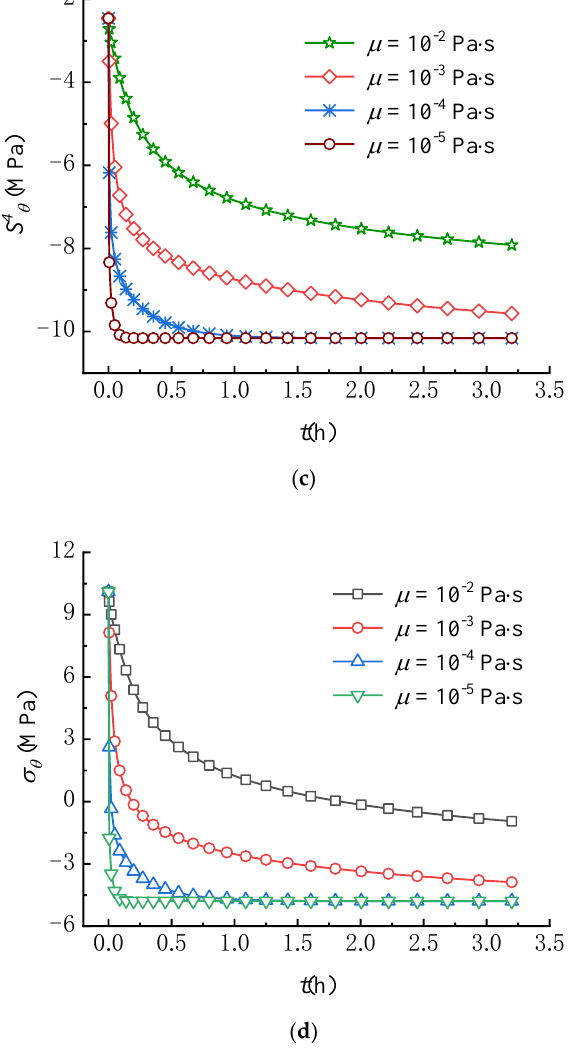
 with different viscosities ( r = 0.25 m). Figure 12. Variations of ( a ) p , ( b ) j , ( c ) S 4 and ( d )   θ and ( d ) σ θ with different viscosities ( r = 0.25